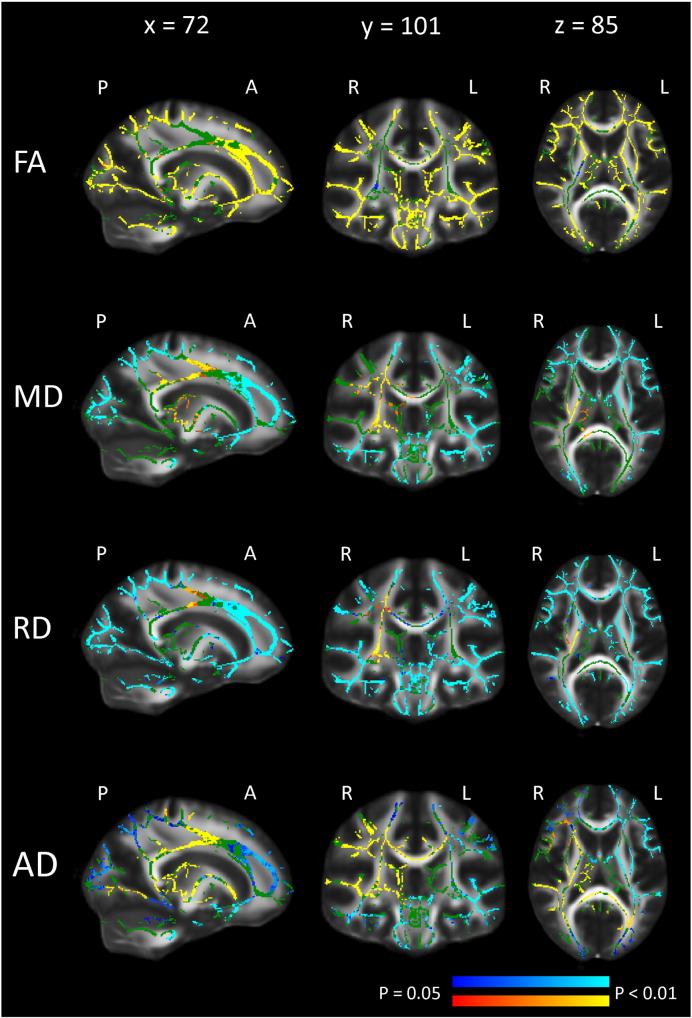
Pattern of change for mean FA, MD, RD and AD.Pattern of change controlling for motion at both time points, sex, age and interval. Regions with a significant (p < 0.05, correction for multiple comparisons across space) increase (yellow and red) and decrease (blue and light blue) in FA, MD, RD and AD are overlaid on the FA skeleton (green), displayed on the FMRIB FA template in MNI space. X, Y and Z are MNI coordinates. P = posterior, A = anterior, L = left hemisphere and R = right hemisphere.